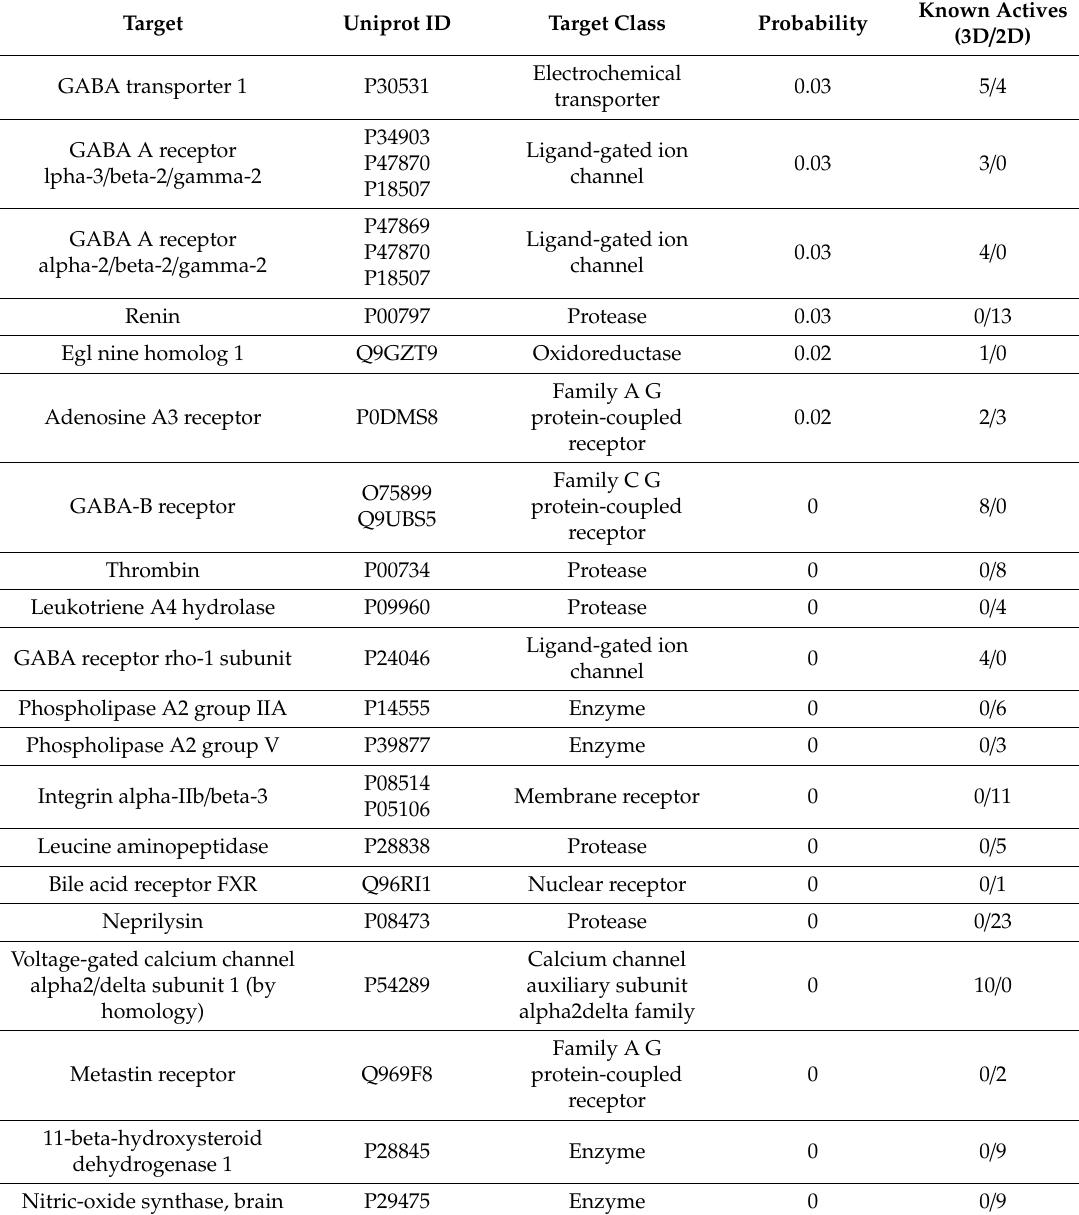
Table 1. Predicted targets for NMP based on its chemical similarity with SwissTargetPrediction drug